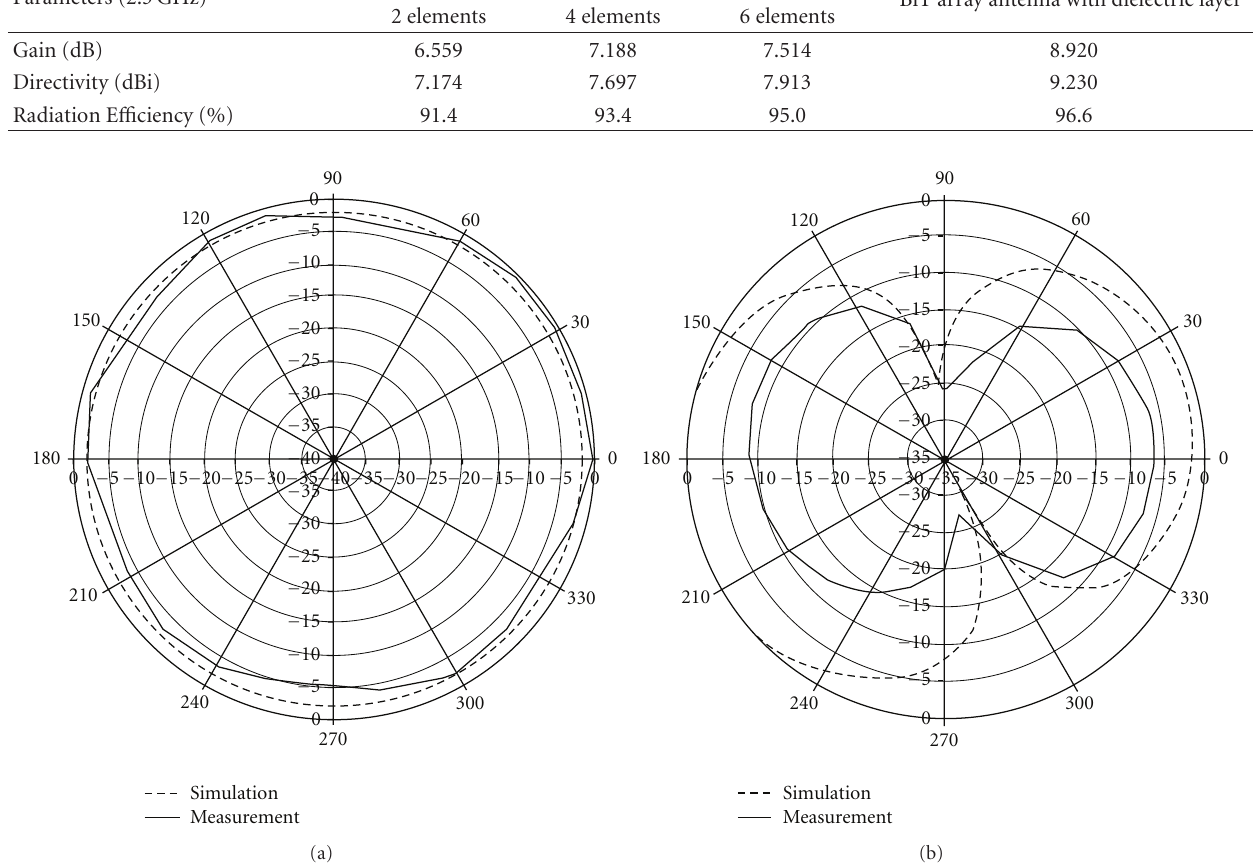
Figure 9: Simulated and measured 2D radiation plot for a six-BiT element array antenna at 2.30 GHz (a) horizontal plane (b) vertical